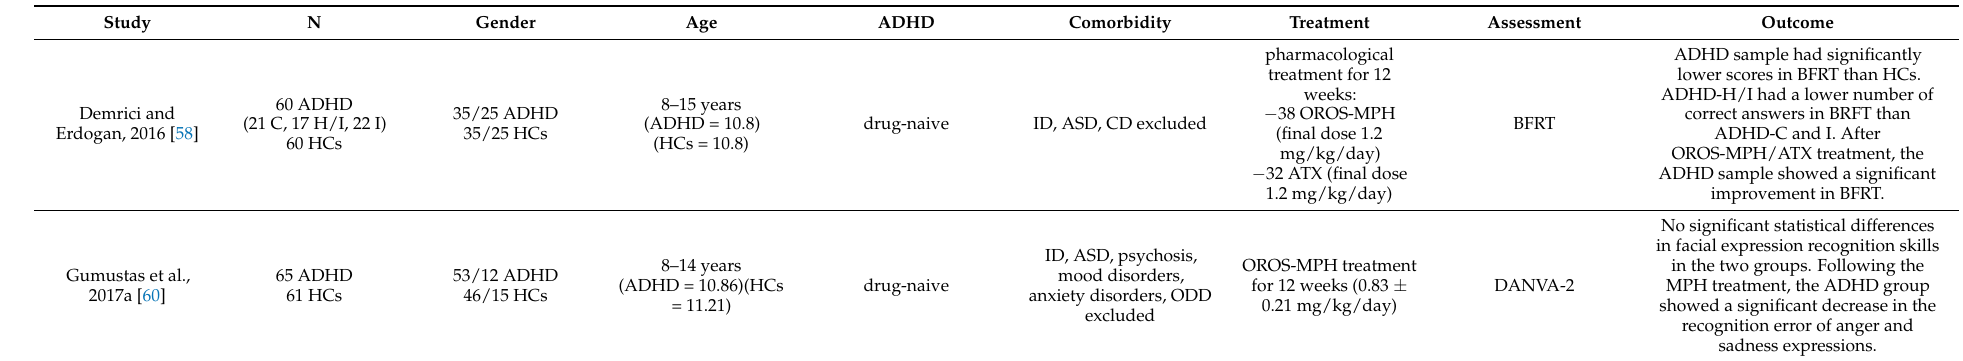
Table 2. Summary details of the included studies: Emotion